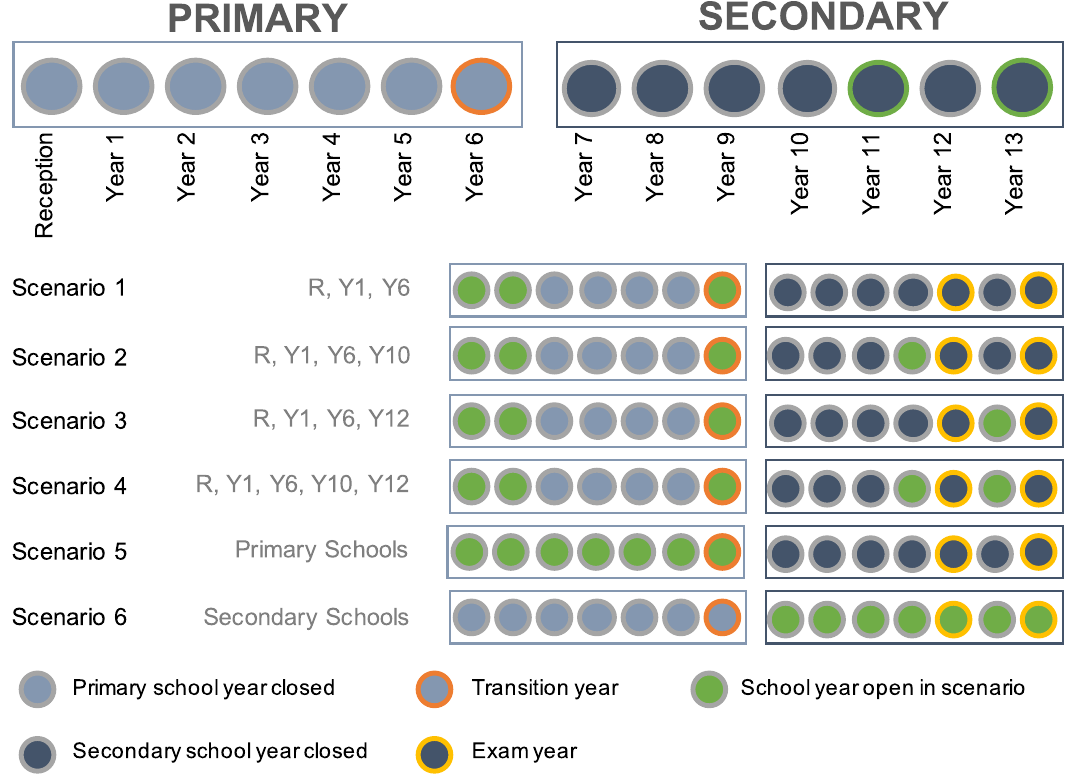
Fig. 2 Breakdown of school years in England and reopening scenarios evaluated. Circles represent school years and each row shows a different reopening scenario. Circles are coloured green to indicate inclusion in each scenario. Circles outlined in orange represent a transition year, circles outlined in yellow represent an exam year.